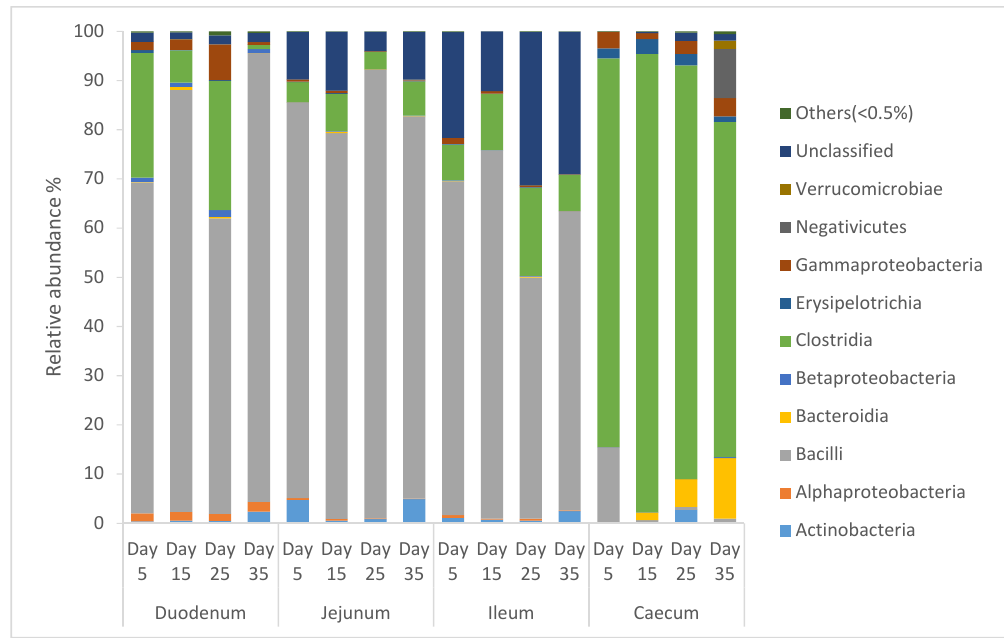
Figure 2. Percentage of relative abundance of bacterial community of local Omani chickens determined from different intestinal segments at different age periods from 16S rDNA libraries.